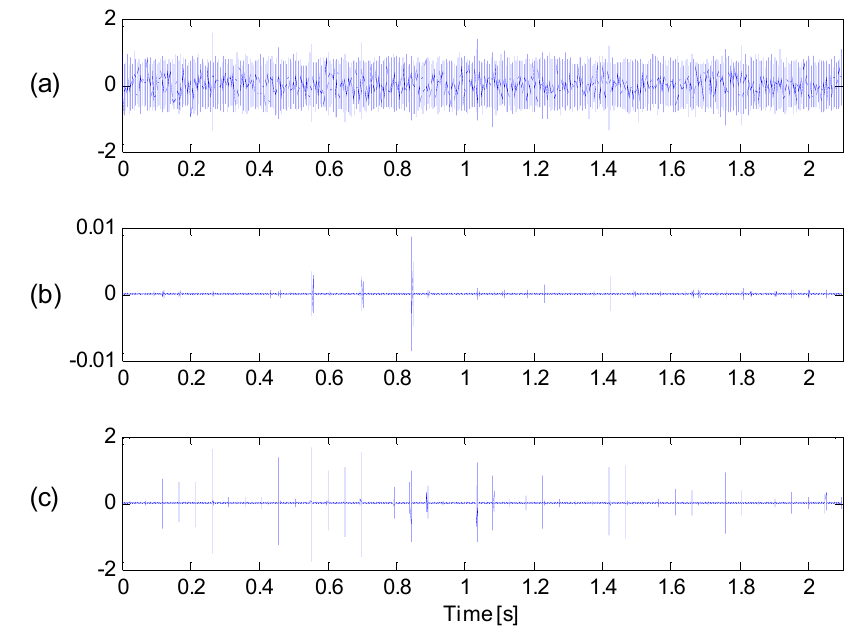
Figure 22. ( a ) The original signal; ( b ) signal filtered by the original kurtogram; ( c ) signal filtered by the proposed method.